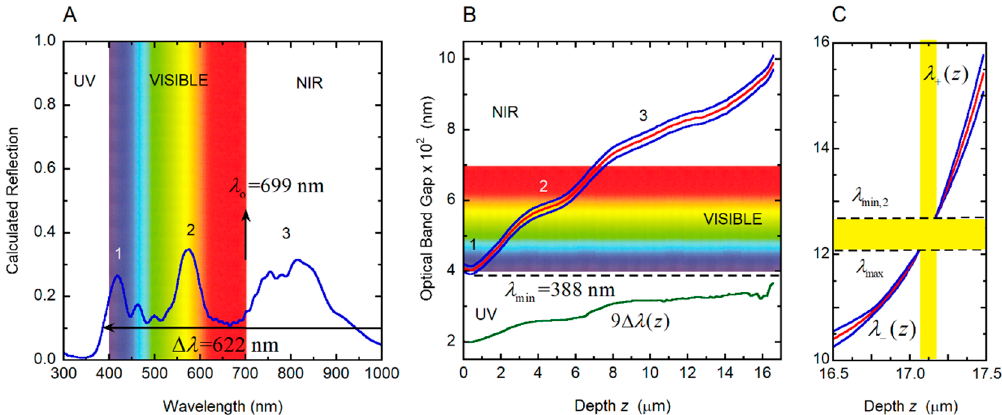
Figure 13. Reflection spectrum and photonic crystal characterization of the cuticle of the C. optima scarab. ( A ) Calculated total reflection spectra of the cuticles of C. optima illuminated with non-polarized normally incident light. ( B ) Variation with depth through the cuticle of the local photonic band gap ( ∆ λ ( z )) and its limits ( λ + ( z ) and λ − ( z )), for the photonic crystal correlated with the cuticle of C. optima scarab. The limits of the reflection band, λ min and λ max , are also indicated. Labels 1, 2, and 3 correlate the spectral positions of the reflection peaks with the local depth dependence of the pitch. ( C ) Photonic crystal characterization in the last micrometer of the twisted structure. NIR: Near infrared; UV: Ultraviolet.